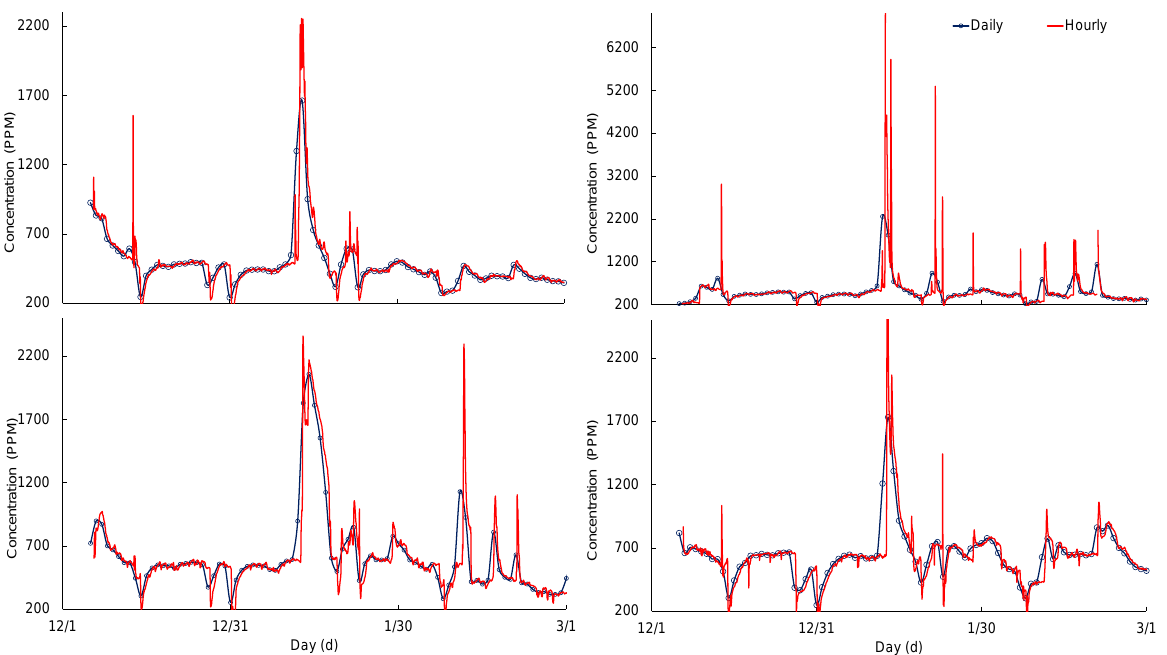
Figure 8. Time series for hourly and daily averaged (calculated from 15 min interval data) salt concentrations for the winter season at the Urban-stream. Table 1. Change (relative to the hourly value) in salt concentration statistics (ppm) when values were averaged to hourly and daily from 15 min